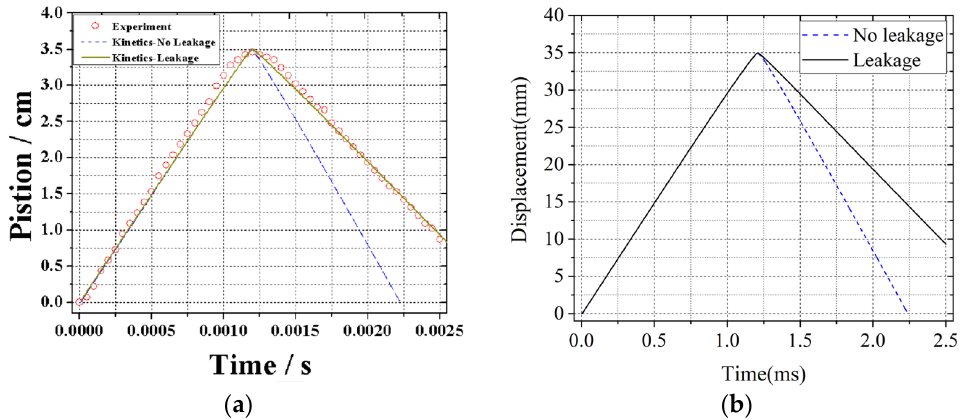
Figure 4. Comparison of the simulation results and the experiment results: ( a ) Curves of piston displacement [8];( b ) simulation curves of piston displacement.